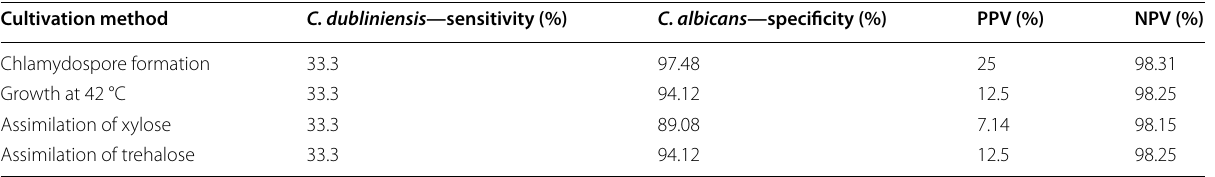
PPV positive predictive value, NPV negative predictive value